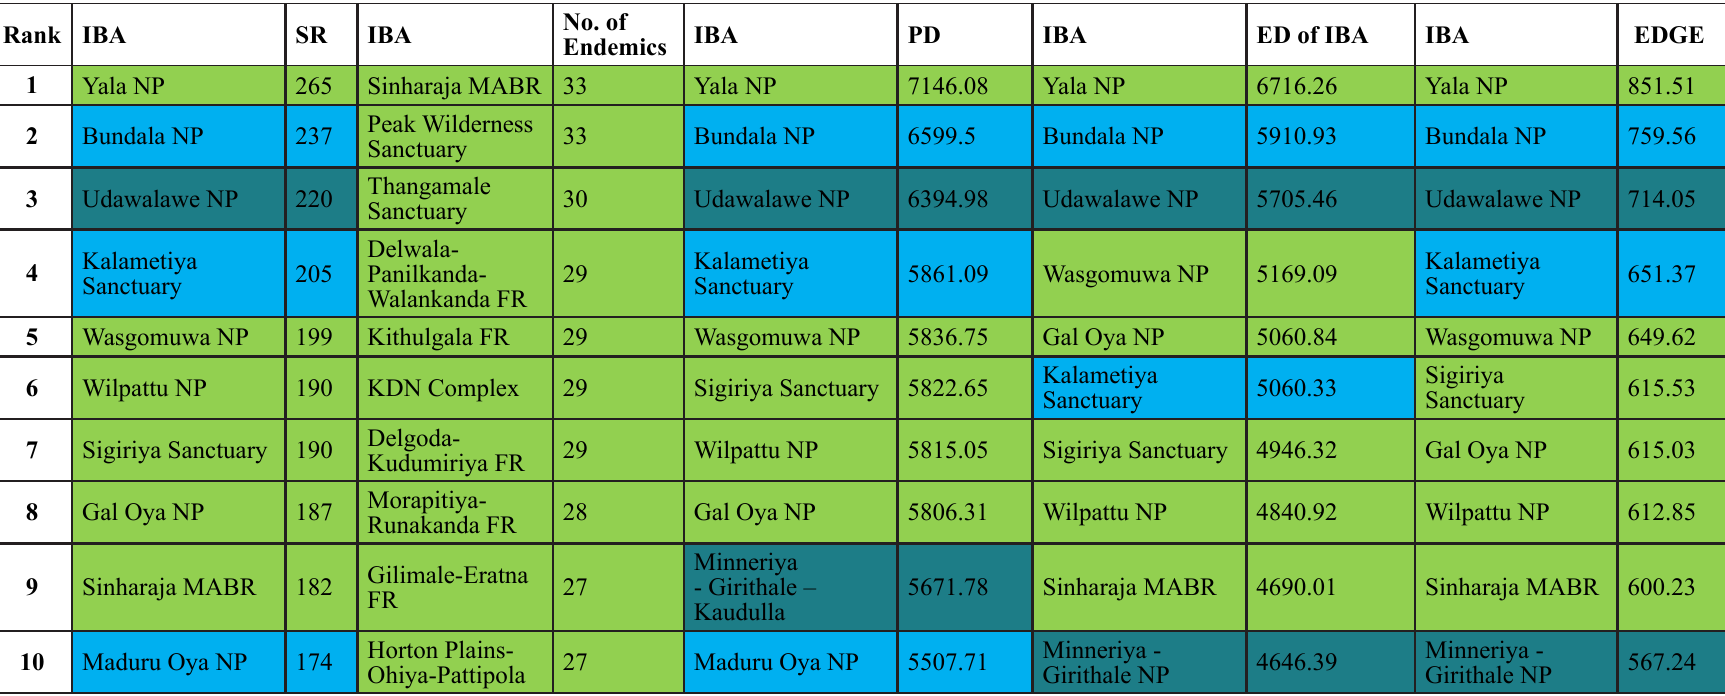
Table 07: IBAs with highest scores in SR, EM, PD, ED and EDGE scores with respect to the habitat type (forest or wetland). Both resident and migratory species are included in the analysis. Colour key: Green- forest IBAs, blue- wetland IBAs and cyan- forest and wetland IBAs. Rank